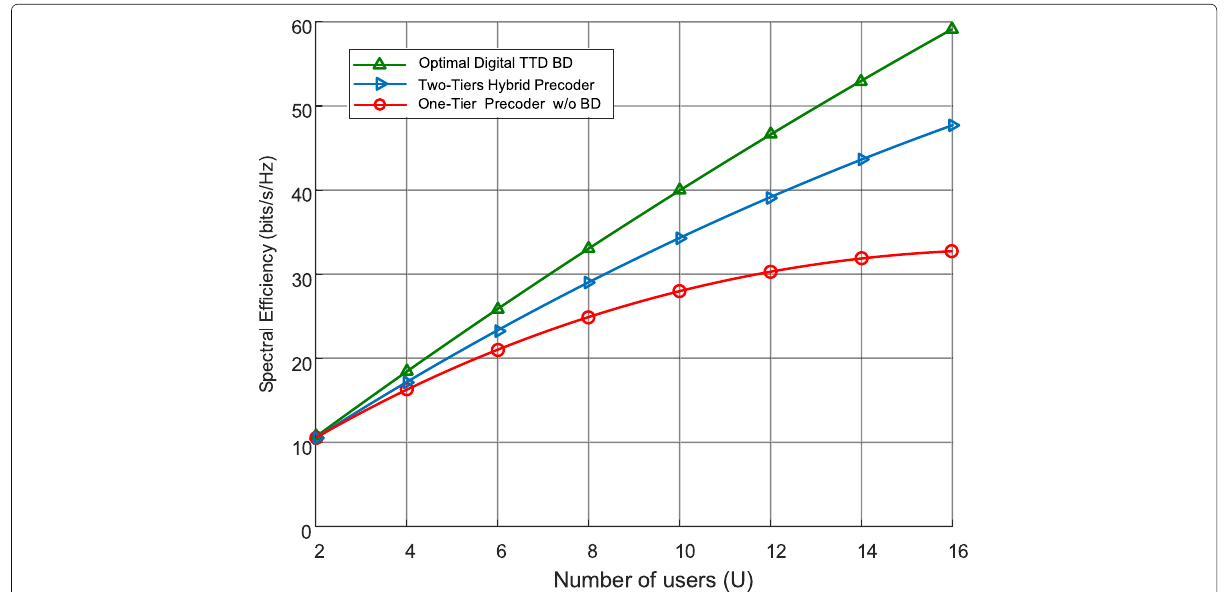
Fig. 7 Spectral efficiency achieved by different precoding schemes versus the number of users in multiuser mmWave MIMO-OFDM systems under SNR = − 15 dB, N t = 256, N r = 16, total bandwidth B = 1.2 GHz, f c = 60 GHz, N t